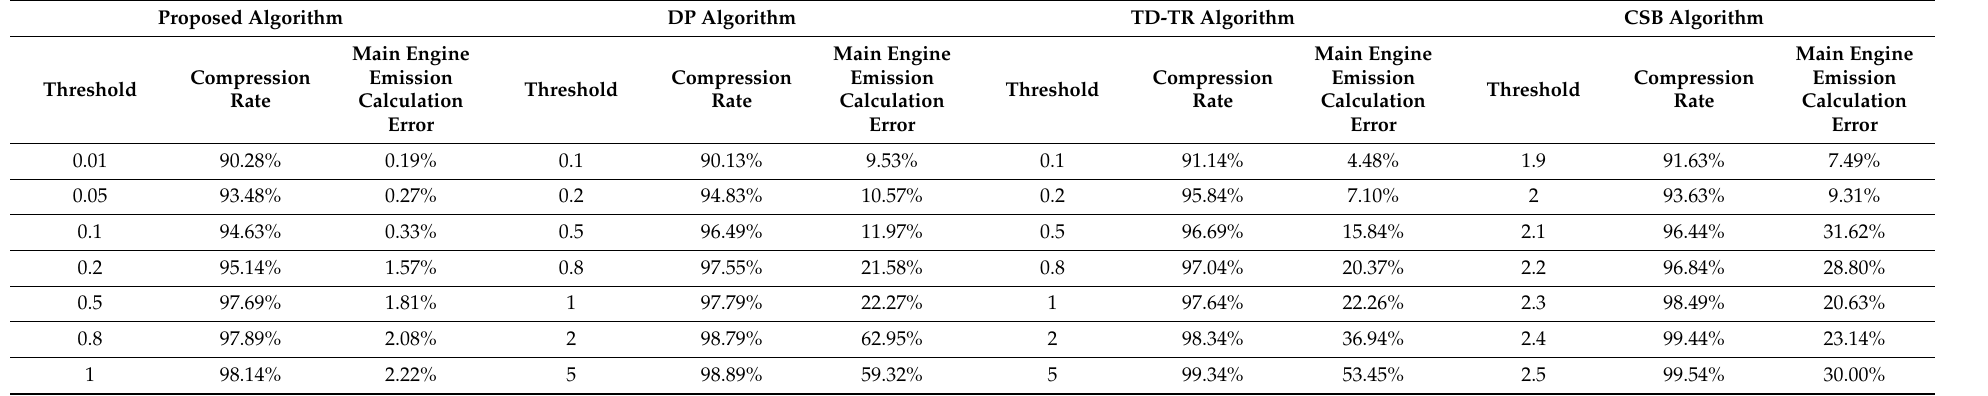
Table 2. Partial performance comparison of each compression algorithm at different thresholds (Shandong Province data). Seven different thresholds are set for each algorithm, corresponding to the computational error of emissions at seven compression ratios. To facilitate the cross-sectional comparison, the determined thresholds will ensure that the data compression ratios under different algorithms are as close as possible.